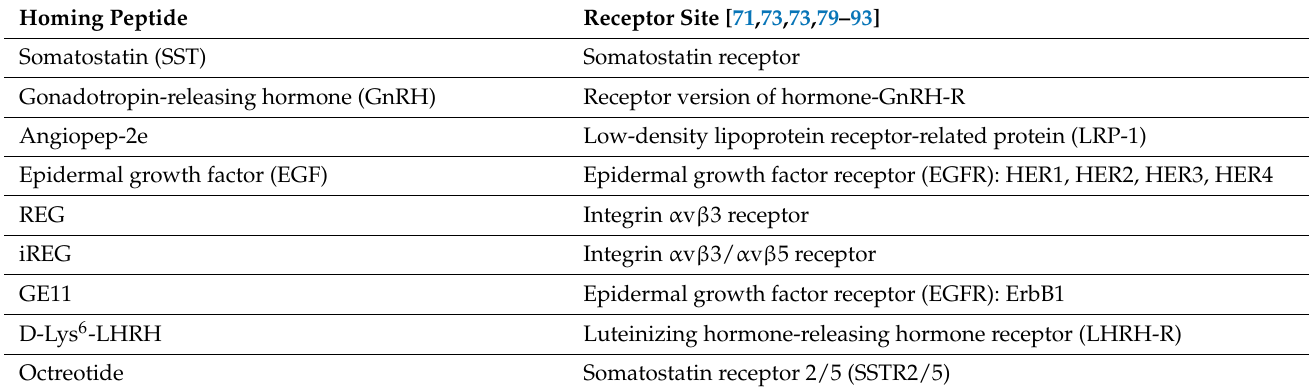
Table 2. Homing peptides used for the development of